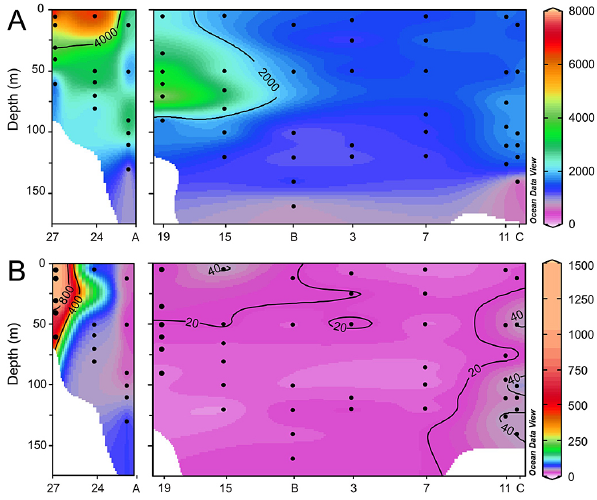
Fig. 2. Abundances (cellsml − 1 ) of total eukaryotes (A) and Amoe- bophryidae dinospores (B) obtained by fluorescent in situ hybridiza- tion (FISH) analyses. The left and right parts of the figures cor- respond respectively to the north-south and west-east parts of the cruise transect.